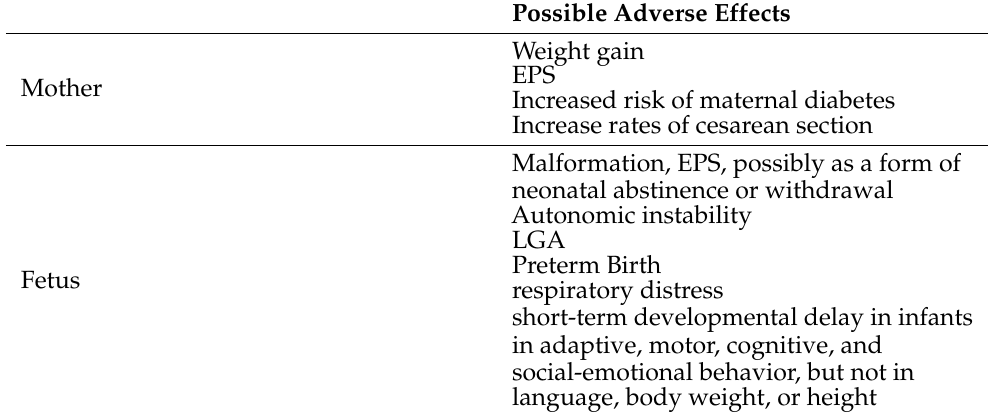
Table 2. Adverse effects of antipsychotics that could be seen in the mother or